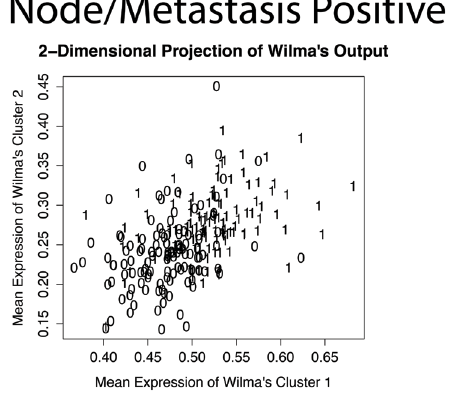
Supplemental Figure 1. Comparison of death, recurrence, and node/metastasis status as metrics to identify proteins with the ability to predict patient prognosis. All number indicate individual patients; 1’s are patients with poor prognosis (death; recurrence; N or M positive at time of diagnosis) and 0’s are patients with good prognosis (living with 3 years of follow up time; non-recurrent with 3 years of follow up time; N and M negative at time of diagnosis). The distinct populations in the death and recurrence plots, showing clear separation of the good and poor prognosis patient clusters, indicate these definitions of poor prognosis can identify groups of proteins with good predictive power. The overlap of these patient clusters in the Node/Metastasis plot indicates this definition has less predictive